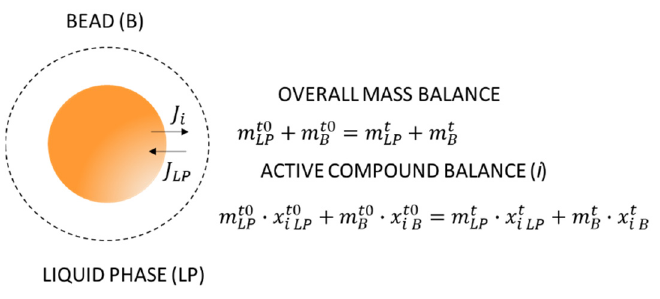
Figure 10. Outline of the bead in the liquid phase during the release of the active compound, with details of the fluxes and mass balances applied to the bead–liquid phase system. Where the subscripts: liquid phase (LP), bead phase (B) and active compound (i), and superscripts: t0 (initial time) and t (process time).